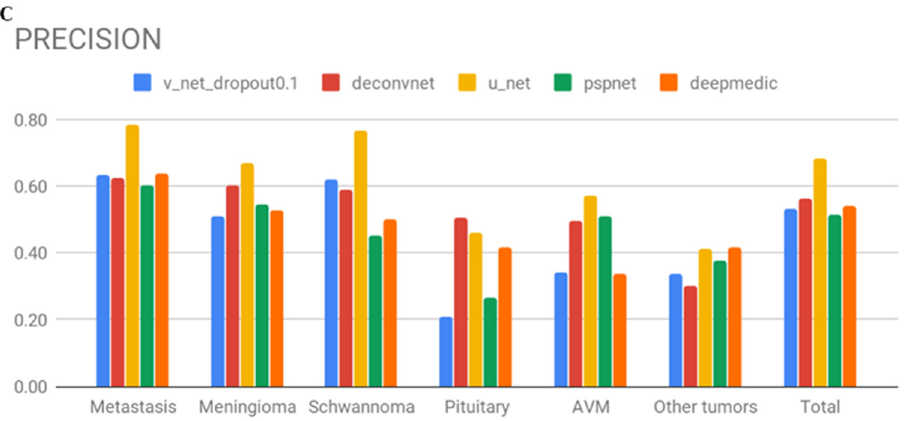
Figure 1. Bar chart results of ( A ) dice score; ( B ) sensitivity; and ( C ) precision of deep learning-based segmentation versus ground truth on different lesion types in the NTUH dataset.